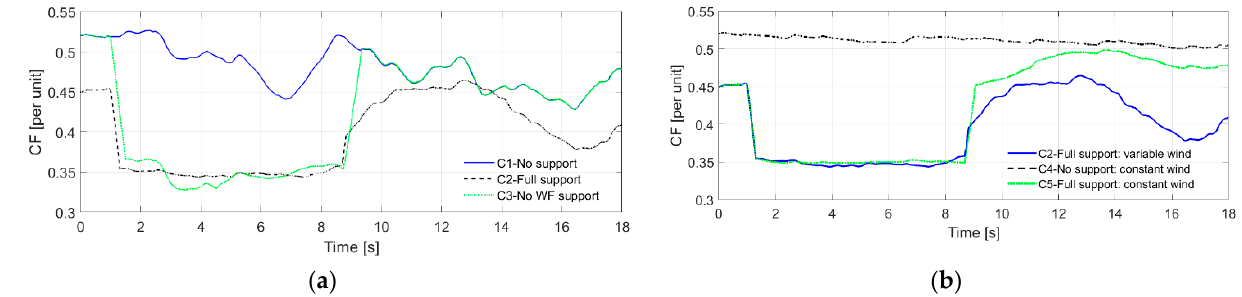
Figure 13. Capacity factor: ( a ) variable wind speed; ( b ) constant wind speed compared to Case 2.